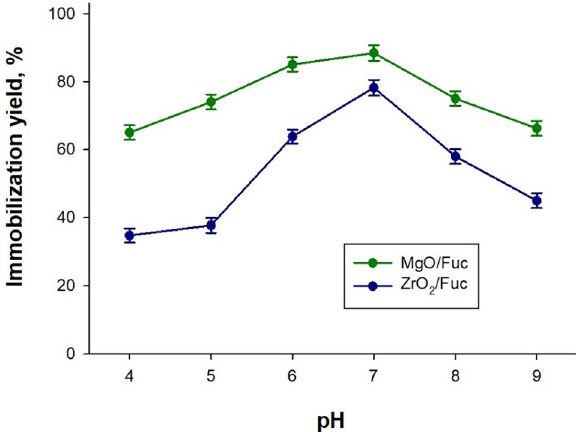
Figure 5. Effect of pH on the immobilization of lipase from Aspergillus niger on MgO/Fuc and ZrO 2 /Fuc.